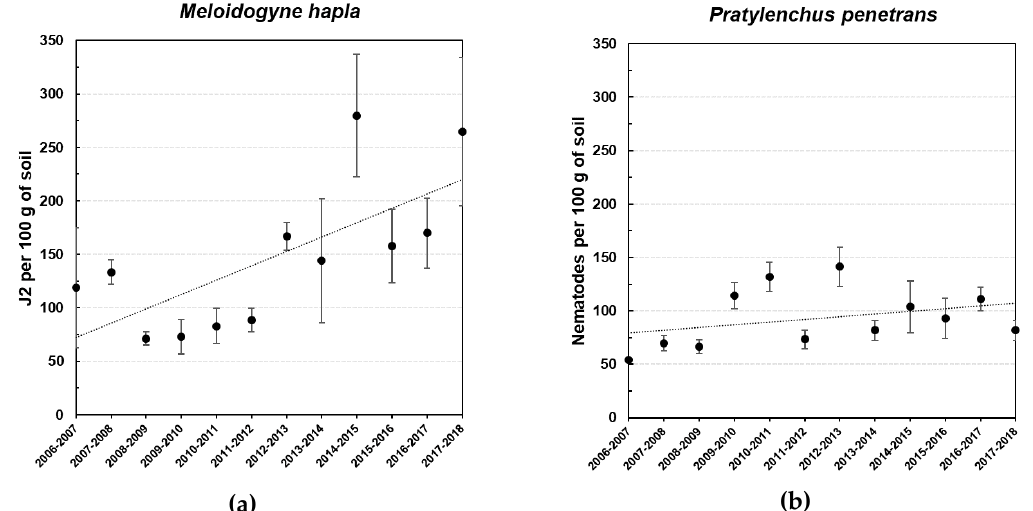
Figure 2. Nematode soil densities per 100 g of soil in non-treated plots before soil disinfestation treatments at two field sites naturally infested with Meloidogyne hapla ( a ) or Pratylenchus penetrans ( b ) through twelve consecutive cropping cycles. Dots are the average of three replicates per season, and bars represent the standard error of the mean.